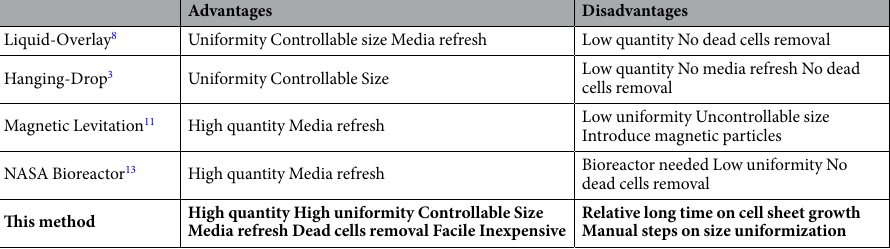
Table 1. Advantages and disadvantages of our tumor spheroid formation method and other popular